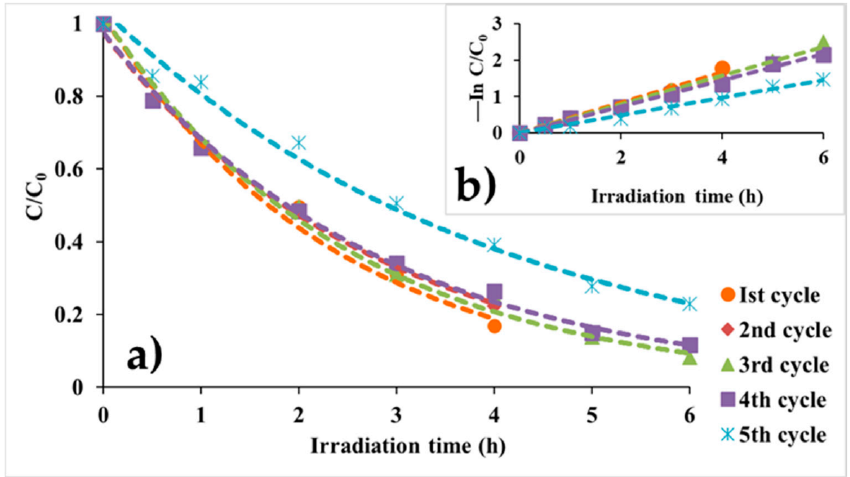
Figure 11. ( a ) Stability test for IBF (C 0 = 5 mg/L, pH = 6.50) degradation over TiO 2 /ZnO/CuPc photocatalyst, and ( b ) corresponding degradation rate constant after five